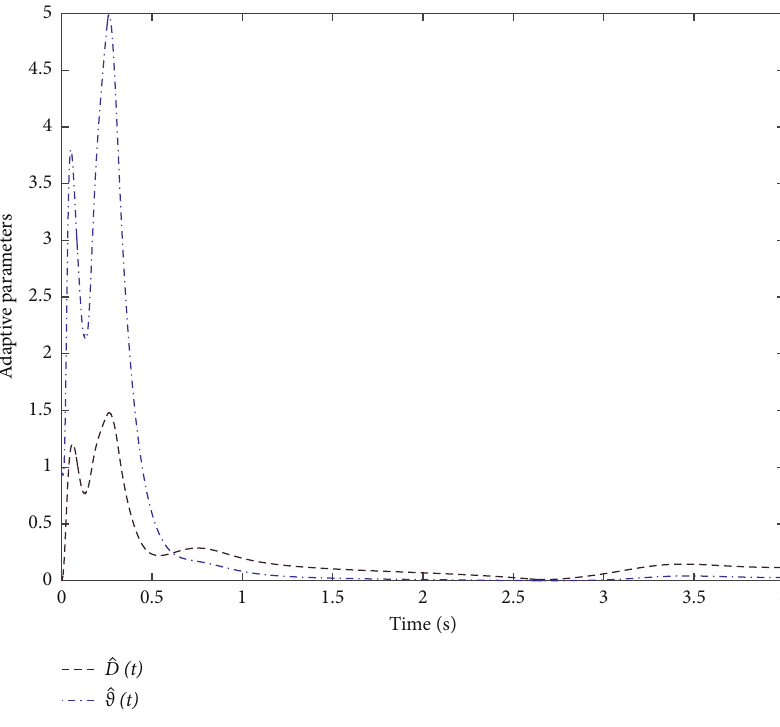
Figure 3: The trajectories of the adaptive parameters under the proposed method.